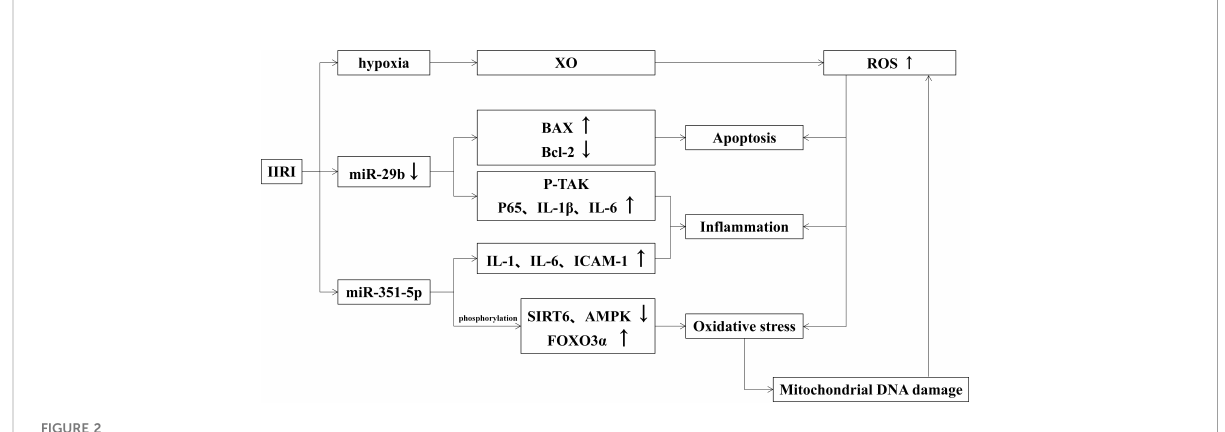
FIGURE 2 Effects of IIRI on intestinal mucosal